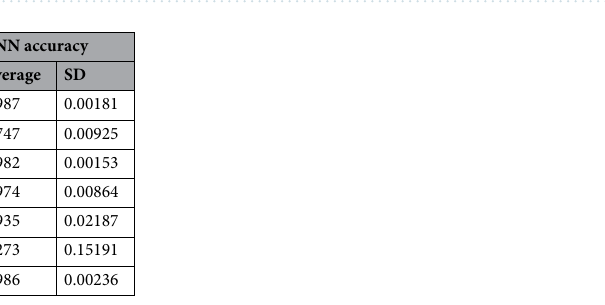
Figure 3. MMT characteristics. ( a ) Normalized transfer characteristics of several µ-Si MMTs showing deviation from the ReLU function. Device A (see the “Methods” section) demonstrates directly proportional dependence of drain current on G1 voltage. See Ref. 19 for G2 transfer curves. ( b ) Measured output curves indicating low saturation voltage. For device geometries, see the “Methods” section. ( c ) Simulated transfer characteristics for a-Si MMTs with different source-G1 overlap ( SGO ). ( d ) Normalized curves to illustrate their deviation from the ReLU